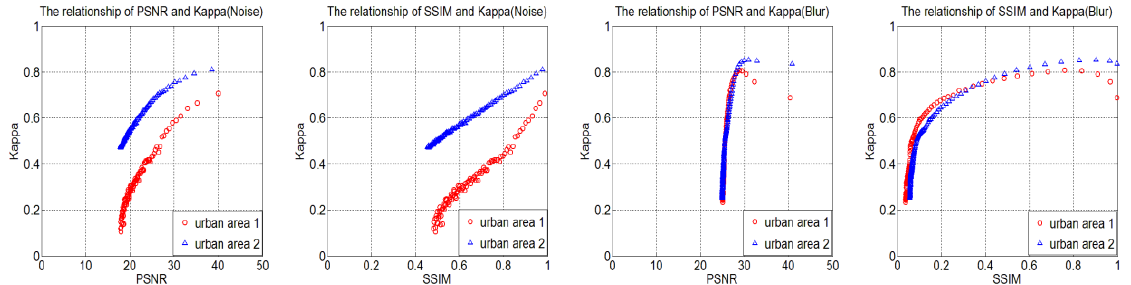
Figure 7. Under the interference of noise and blur, the relationship of the Scale factor σ , PSNR, SSIM and